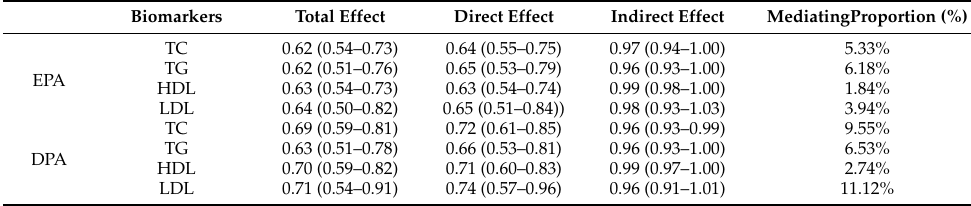
Table 4. Analysis of total effect, direct effect, indirect effect, and mediating proportion of car- diometabolic biomarkers between beneficial fatty acids and CVD mortality among participants with CMD in NHANES III and NHANES 1999–2014 a